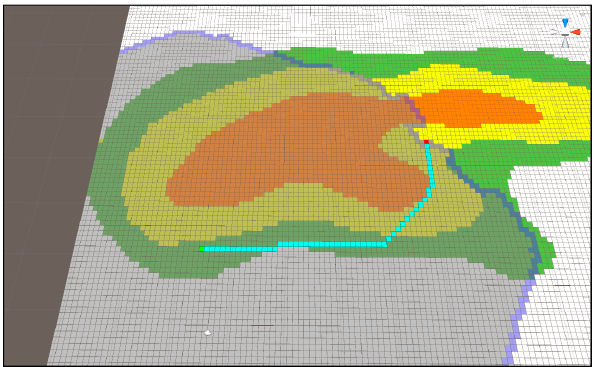
Figure 20. Shortest distance search result of improved Dijkstra Algorithm (1).